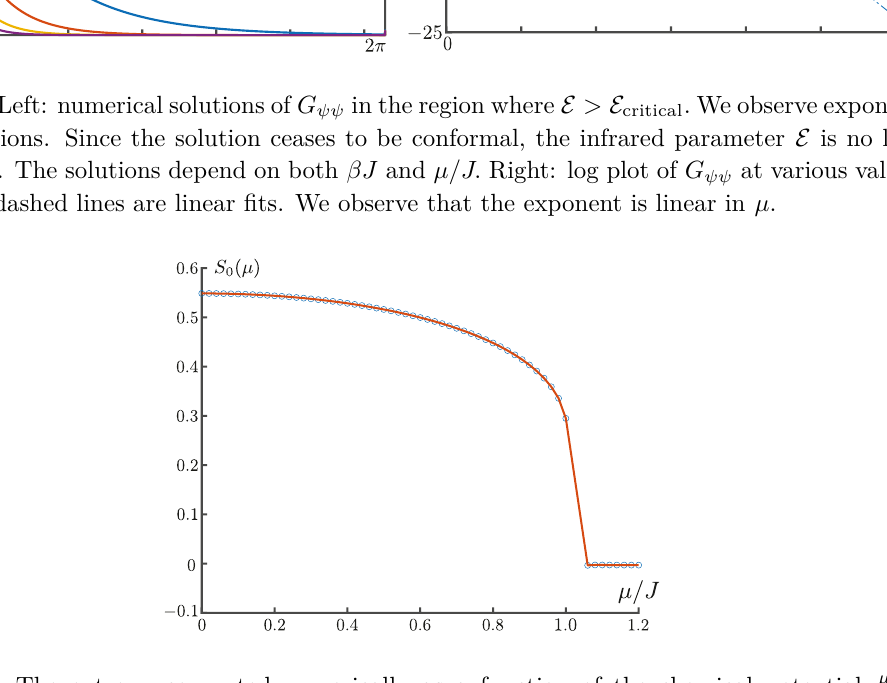
Figure 8 . The entropy computed numerically as a function of the chemical potential µ . For J each value of µ, we compute the free energy and entropy on a numerical grid of size 2 25 at small temperatures and extrapolate the zero temperature entropy. Note at µ = 0 , we obtain S (0) ≈ 0 0 . 5484 which is close to the value predicted by the index log(2 cos π ) ≈ 0 . 5493 . The transition 6 happens slightly above µ = µ = J, where the exponential decaying solution (2.59) starts to appear. c Extrapolating the precise zero temperature entropy becomes involved near the transition